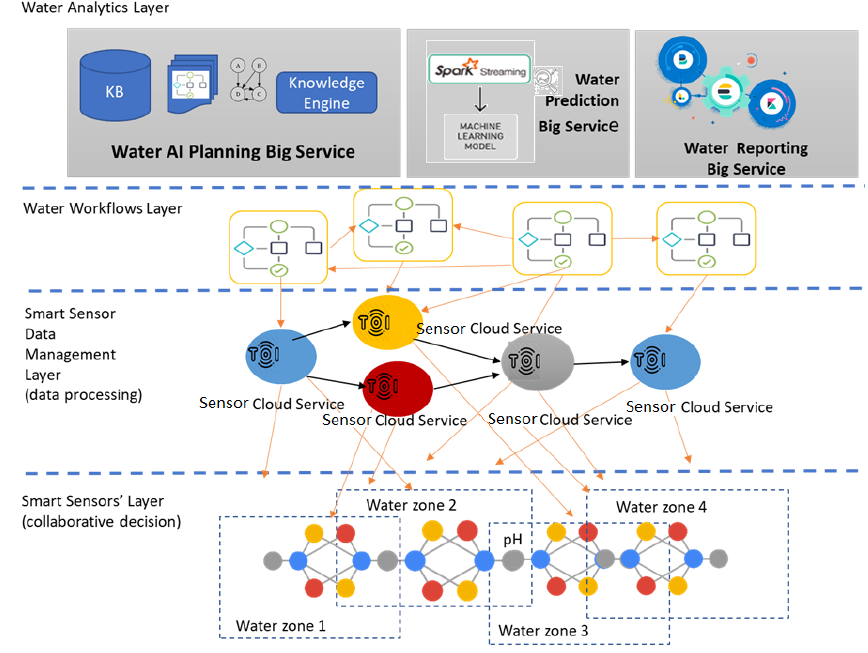
Figure 1. Layered model of the smart water monitoring framework. The proposed framework is composed of four layers: smart sensors’ layer, data management layer, workflows layer, and water analytics